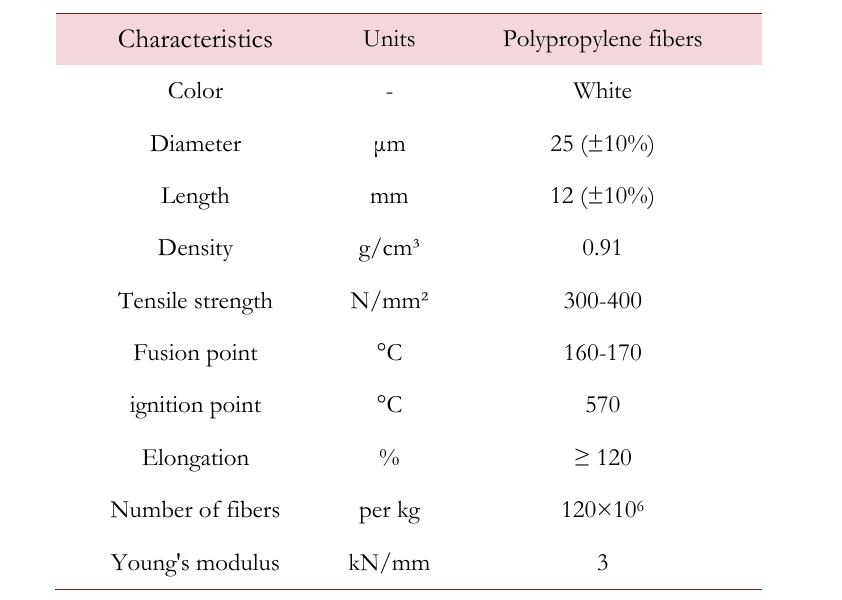
Table 7: Technical characteristics of polypropylene fibers used [54].